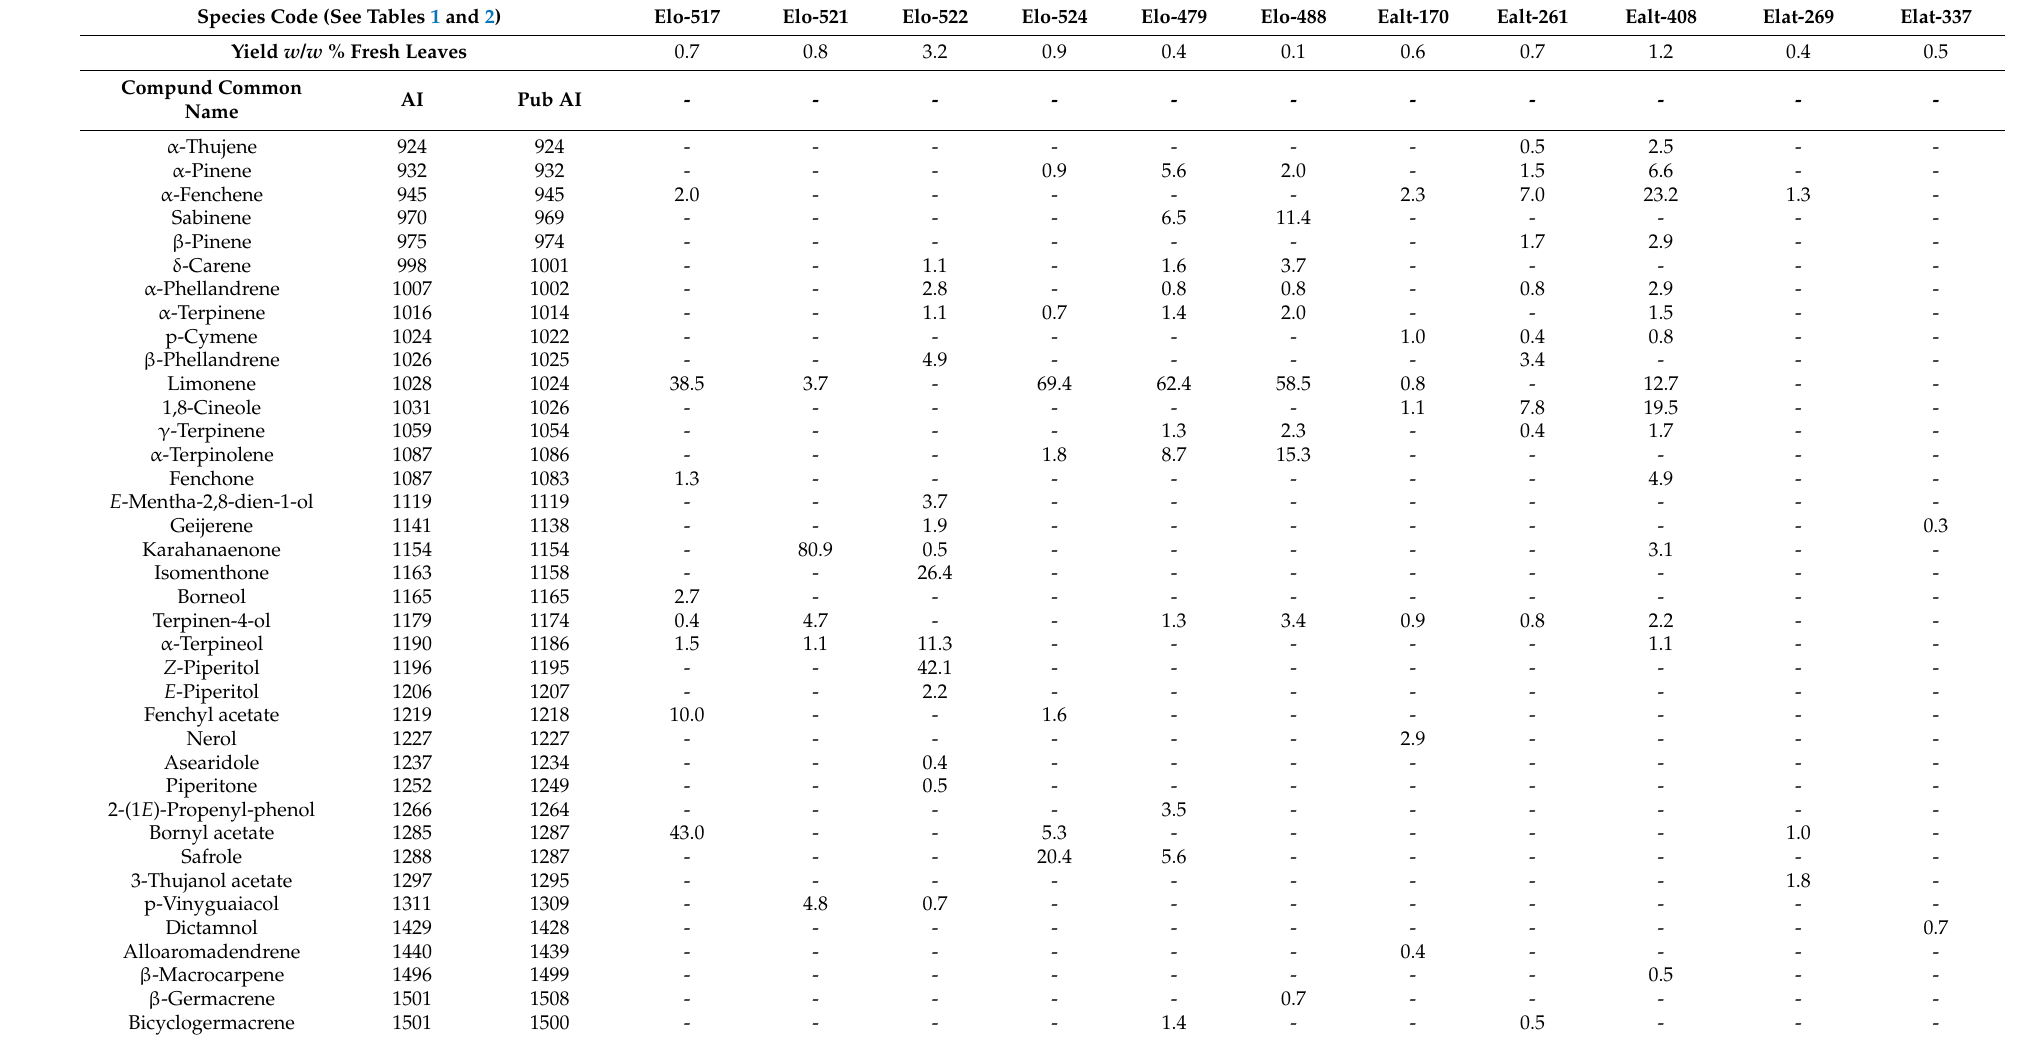
Table 6. Chemistry of essential oils from Eremophila longifolia (Elo), E. alternfiolia (Ealt) and E. latrobei